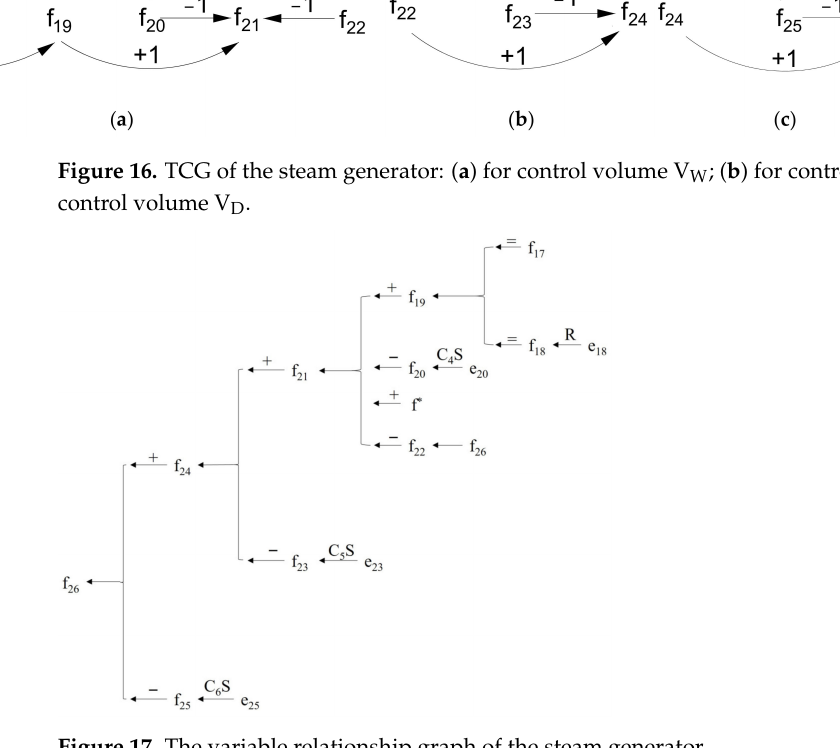
Figure 17. The variable relationship graph of the steam